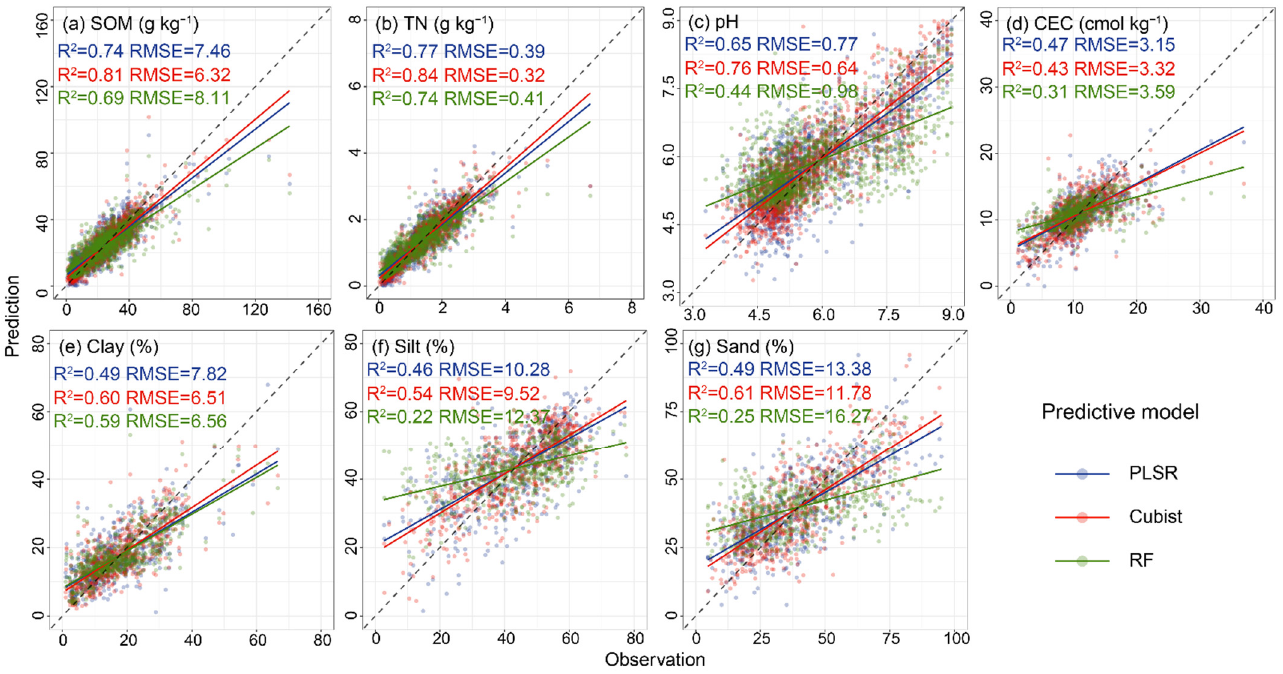
Figure 3. Reflectance spectra for soil samples under different SOM levels in the ZSSL.